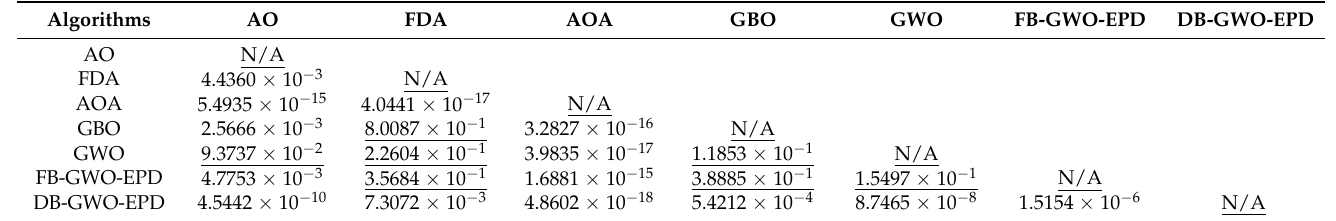
Table 8. p -values calculated for the CEC2017 benchmark functions ( p -values ≥ 0.05 have been